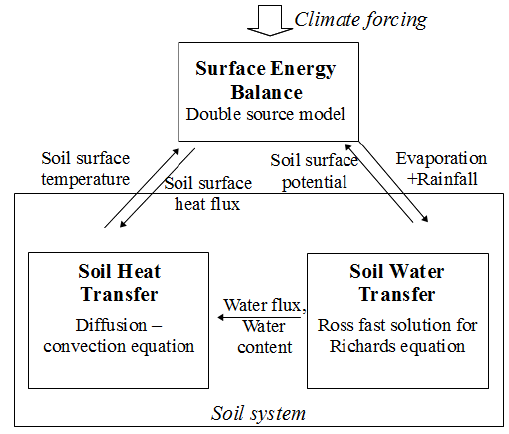
Figure 1. The FHAVeT model coupling